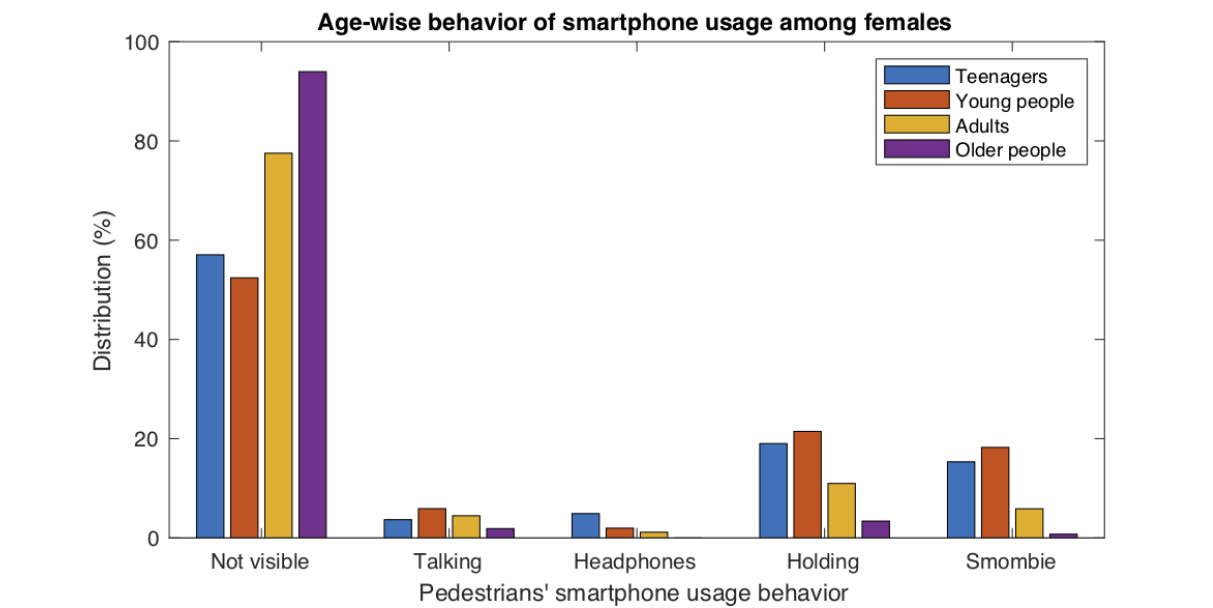
Figure 9. Smartphone usage behavior of females across different age ranges.